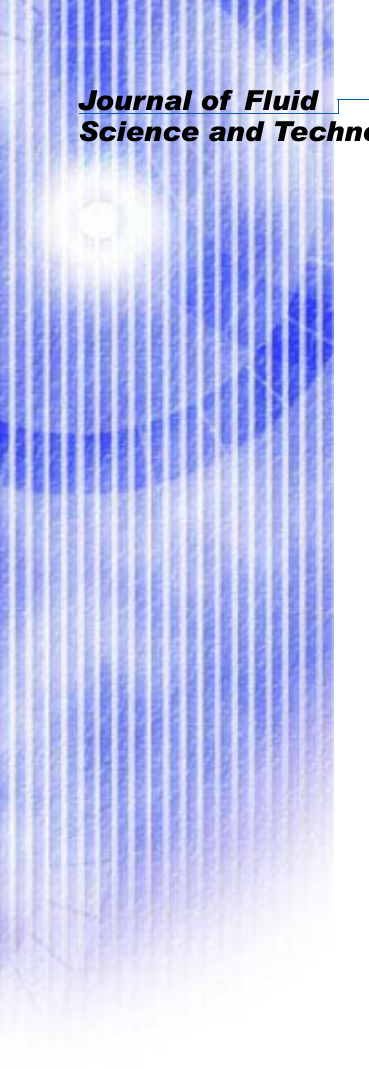
Fig.5 Velocity histograms from PEPT measurement for 3 flat blades, 600rpm. (a)